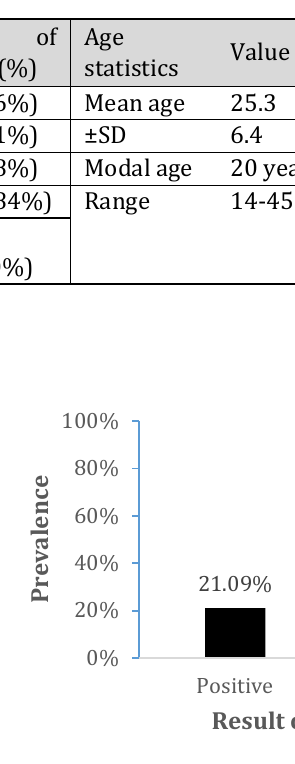
Table 1. Demographic data of the pregnant women who participated in